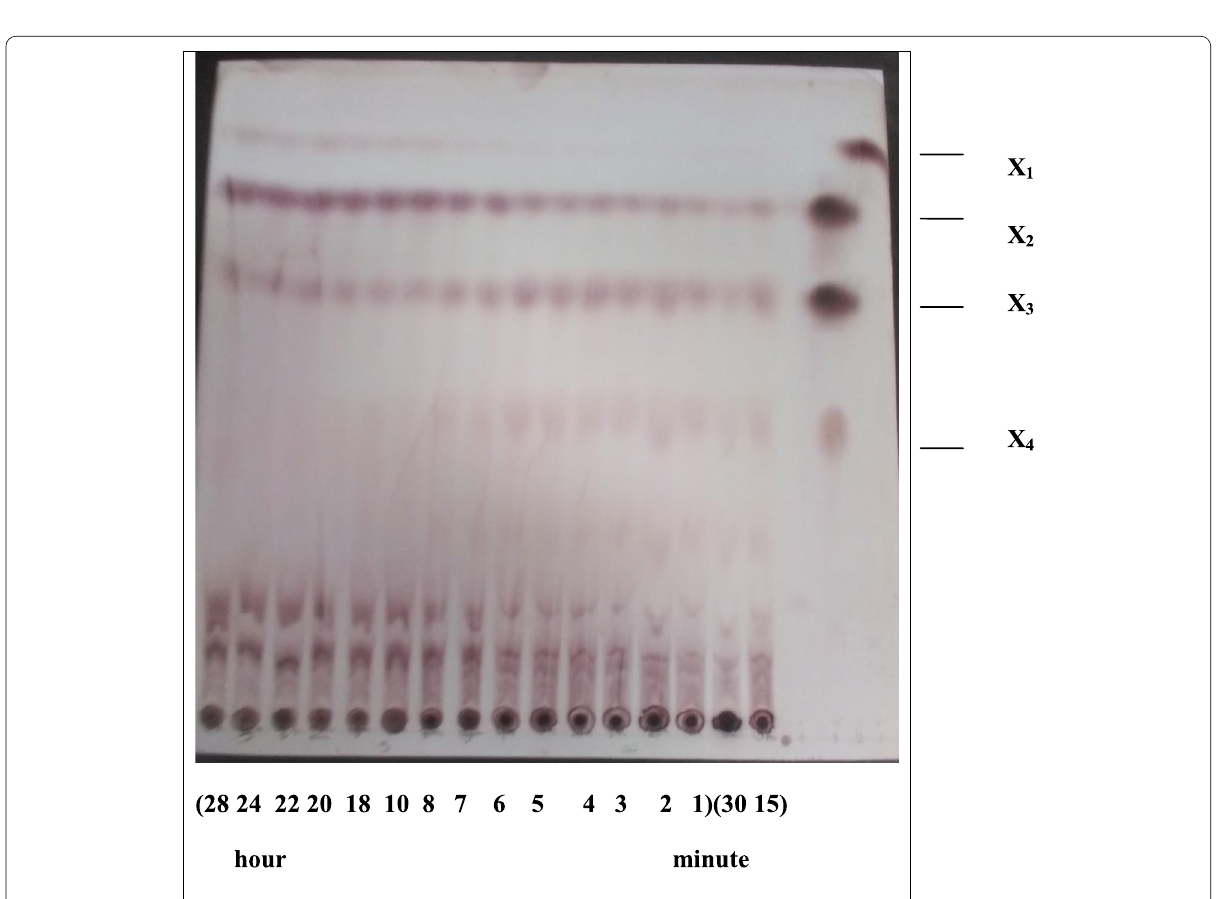
Fig. 12 TLC plate of hydrolysis product of xylan by A. terreus xylanase at various periods. X1, mono; X2, Di; X3, Tri; X4, Tetra; lan 1, 15 min; lan 2, 30 min; and lan 3 to lan 14 are from 1 to 28